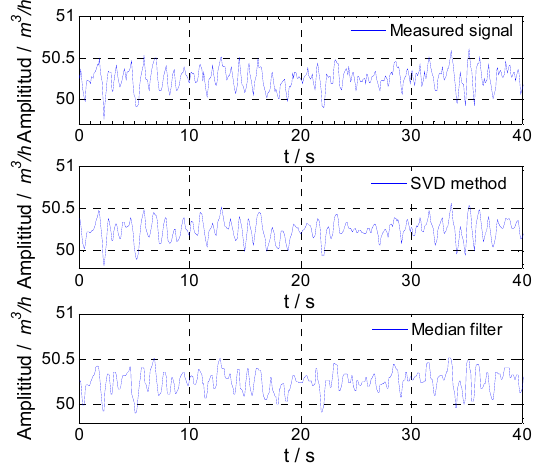
Figure 11. Experimental result for facility fluctuation signal.